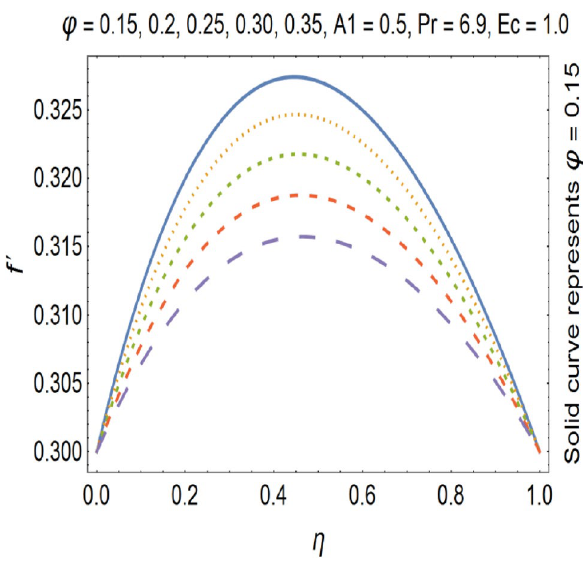
Figure 12. Velocity profile for various